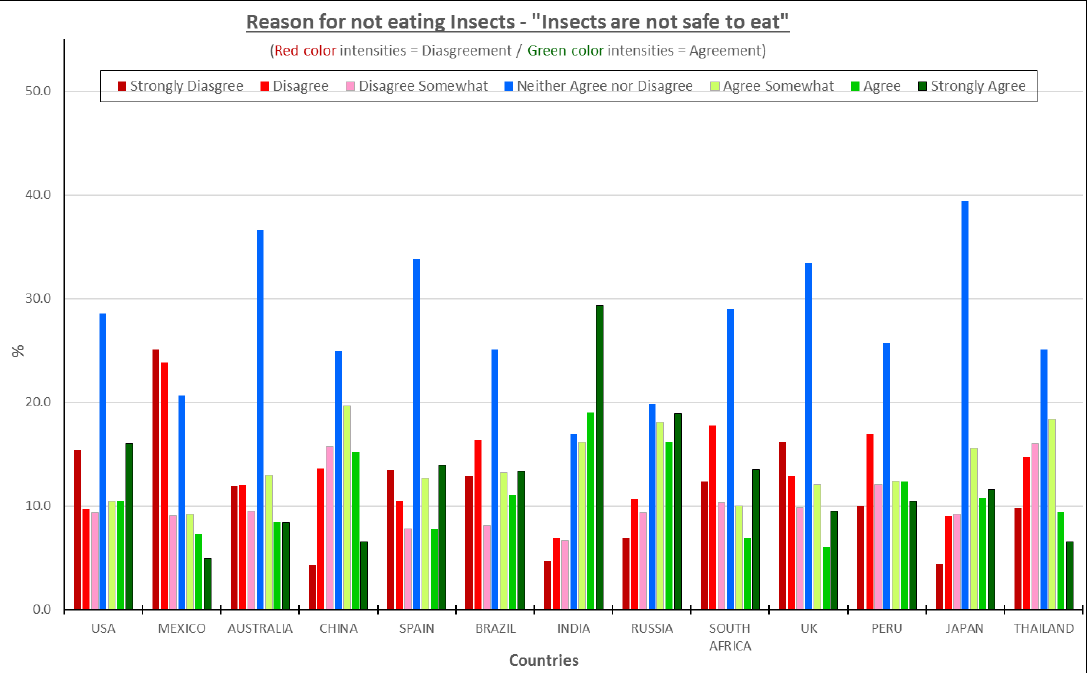
Figure 7. The reasons for not eating insect products—“Insects are dirty/filthy”. For those three countries, the percentages of consumers, ranged from approximately 60–70%. Less than 35% of Mexican consumers agreed with that statement, the lowest of all the countries. Peru